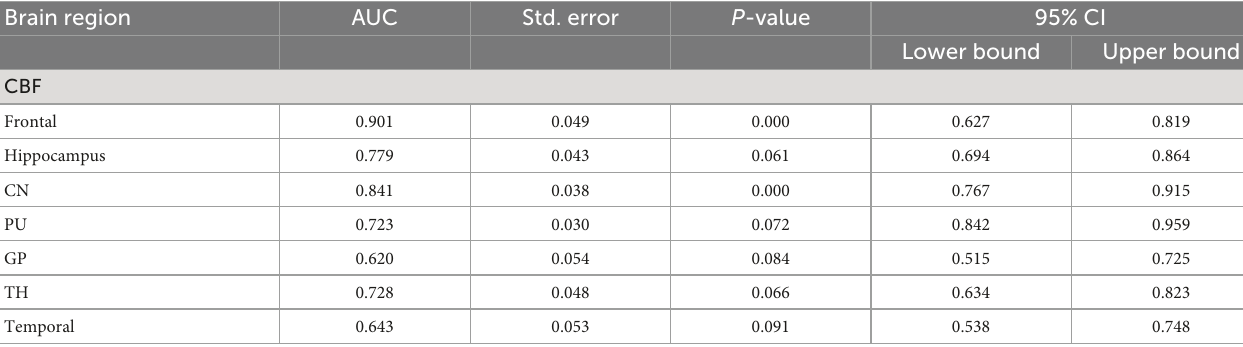
TABLE 4 Receiver operating curve (ROC) curve analysis results of CBF in brain regions of ADHD children ( n = 102). Brain region AUC Std.